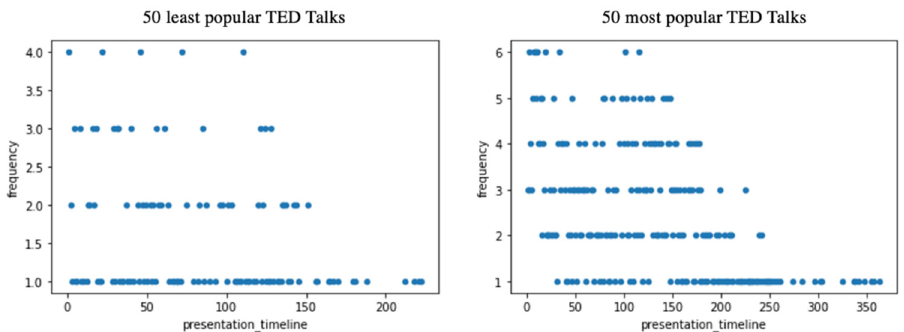
Figure 1. The frequency of audience laughter in the top 50 least popular ( left ) and top 50 most popular ( right ) TED Talks. The x -axis shows the presentation timeline or the n th position of the sentence when audience laughter occurred during the presentation. Frequency counts for each sentence’s n th position are shown in the y -axis.